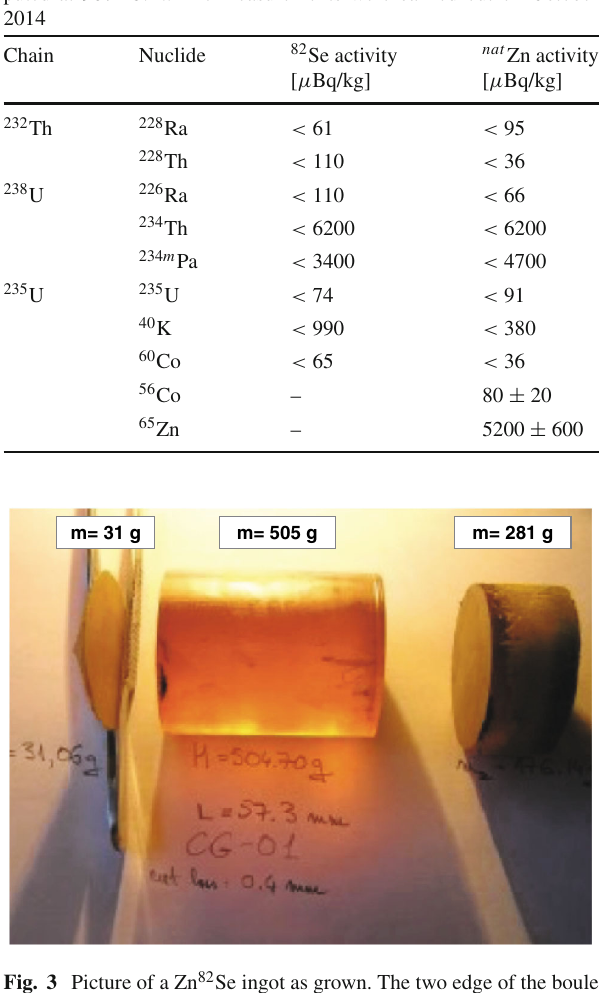
Fig. 3 Picture of a Zn 82 Se ingot as grown. The two edge of the boule are removed, while the central part is processed for the realization of the final crystal for the CUPID-0 detector